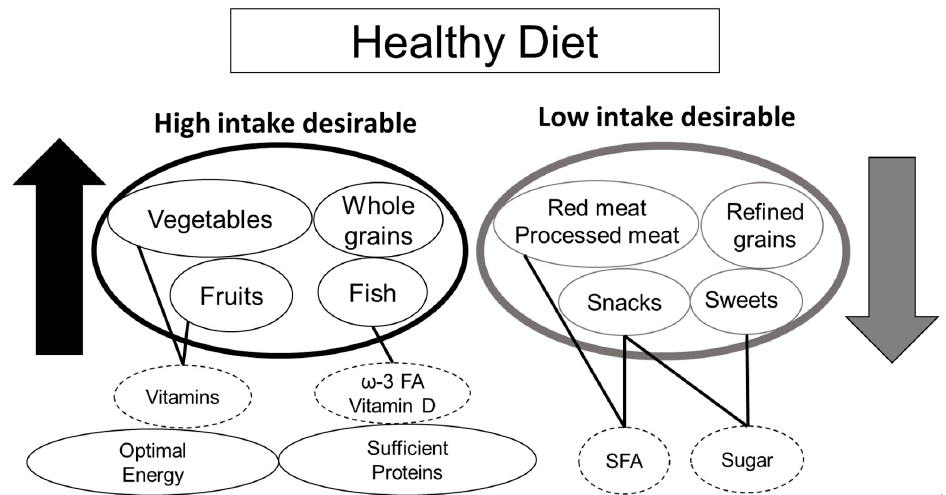
Figure 3. Healthy diets for older adults with diabetes. A healthy diet (Mediterranean-like diet) that is recommended for older patients with diabetes for the prevention of frailty and cognitive impairment. Food products that are recommended to be increased are indicated with black circles, whereas those recommended to be decreased are indicated in gray circles. Dashed circles indicate nutrients that are rich in each food product. ω -3 FA, omega-3 fatty acid; SFA, saturated fatty acid. Evidence of associations of energy, macro/micronutrient intake, dietary pattern and mortality, frailty, sarcopenia, and cognitive impairment is summarized in Supplementary Table S2.